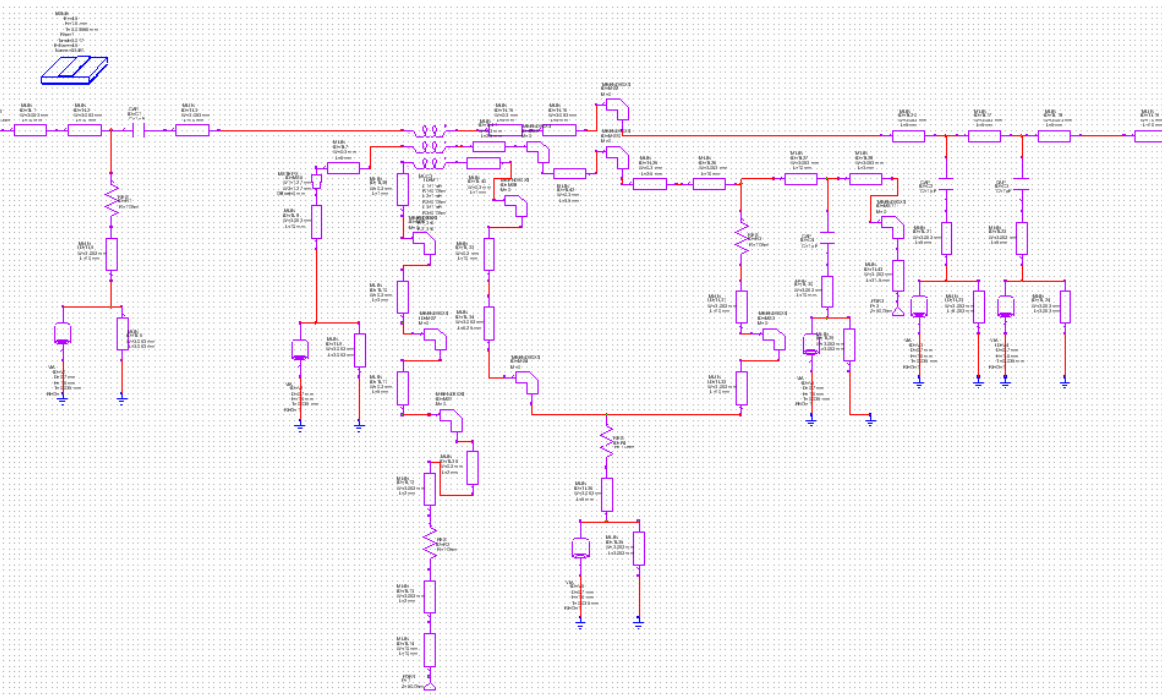
Figure 8. Schematic of the microstrip board for power detector use.